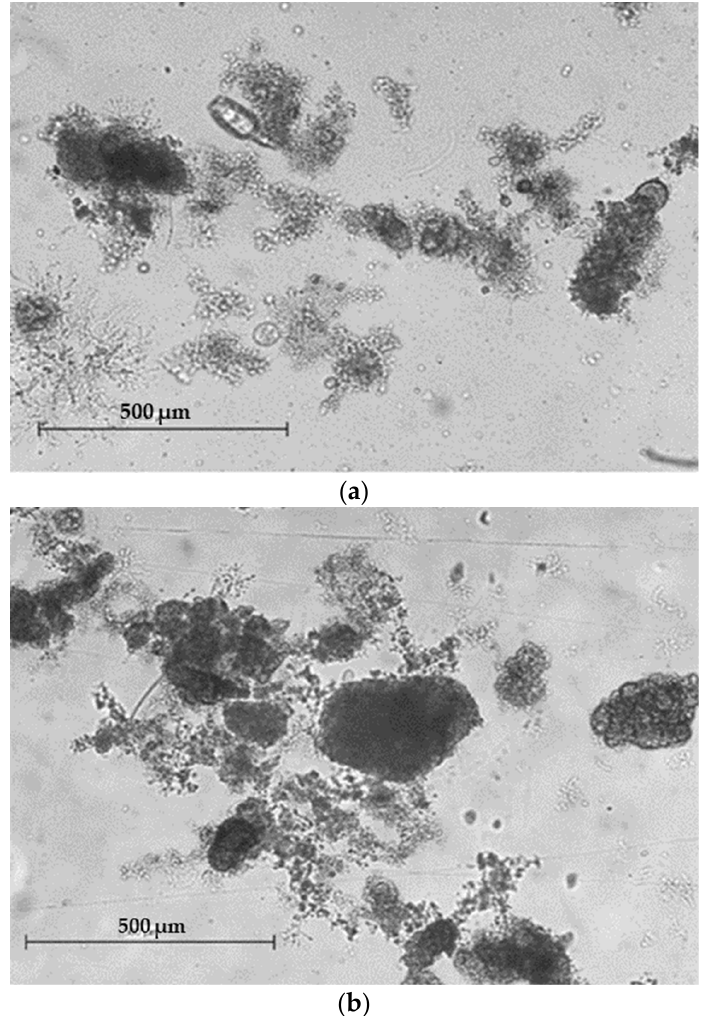
Figure 3. Typical microscopic image of the sludge from the anaerobic reactor ( a ) and the aerobic reactor ( b ). Scale bar: 500 µm.